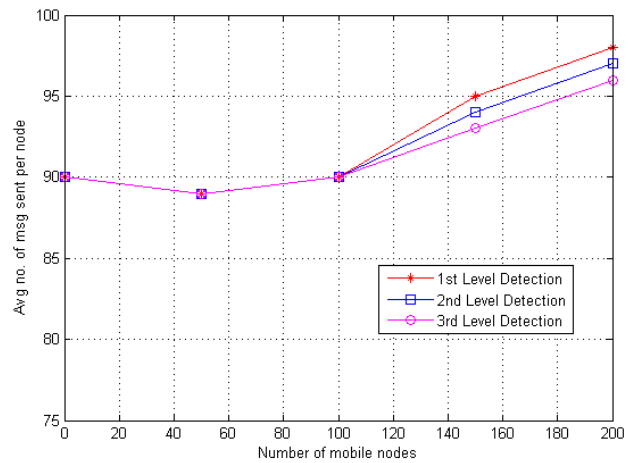
Figure 9. Average amount of messages transmitted per mobile